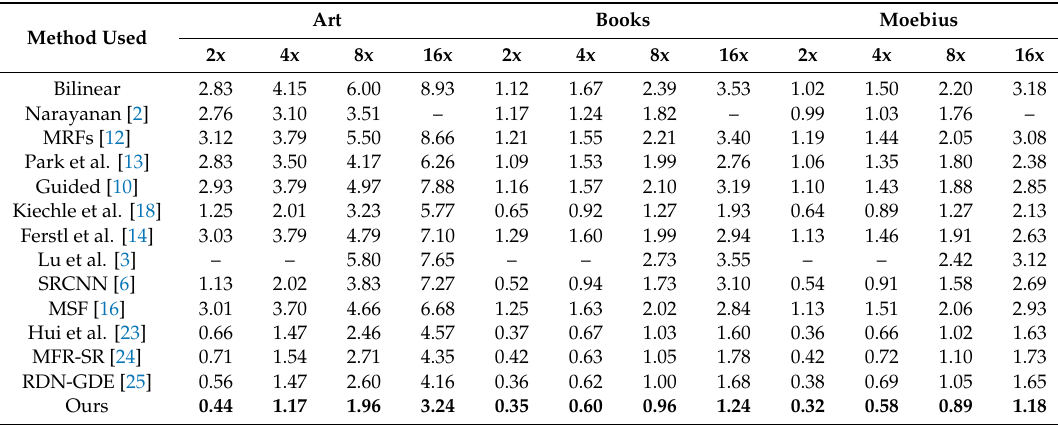
Table 1. Quantitative comparison (in RMSE) on dataset A .